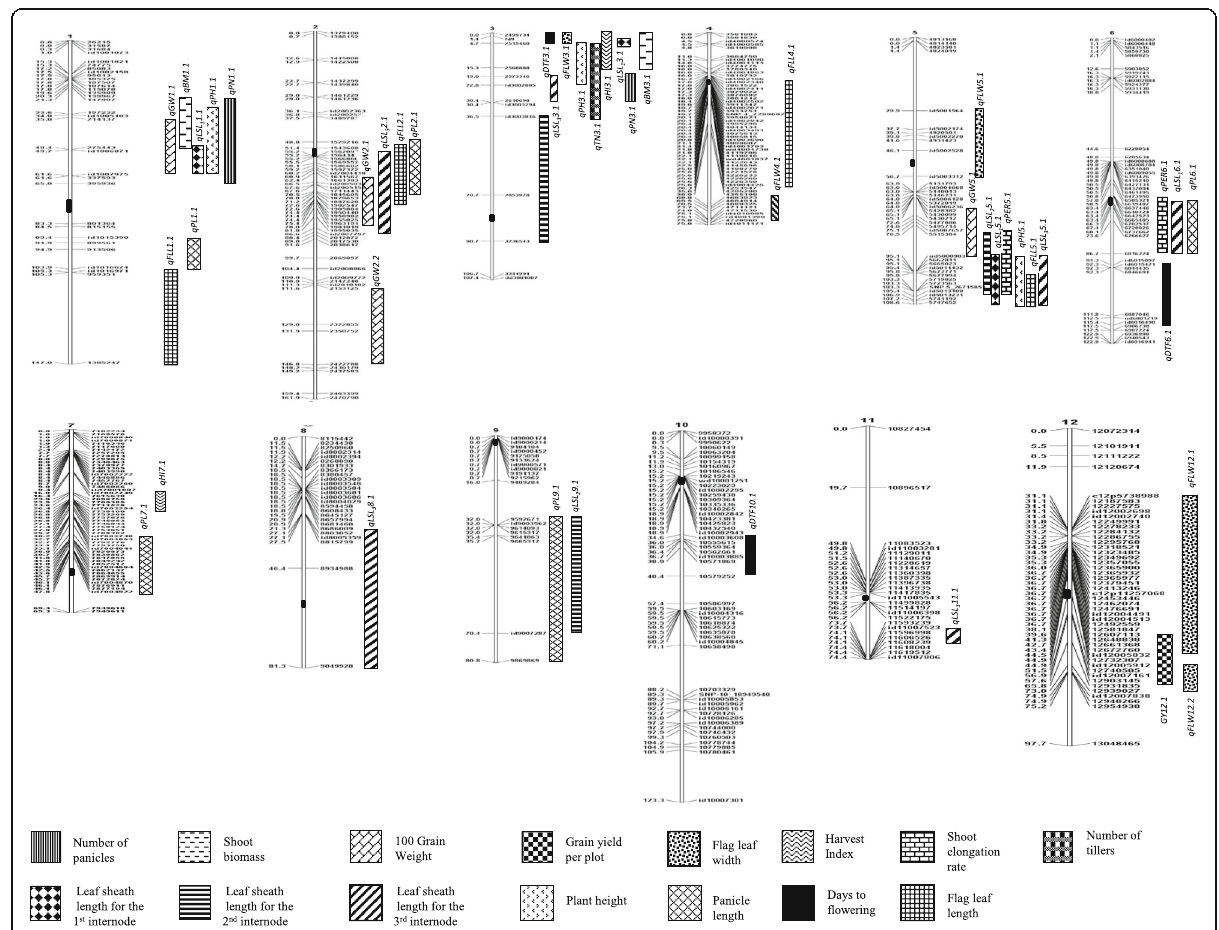
Fig. 2 Linkage map of a RIL population (F 7 ) population derived from a cross between Ciherang-Sub1 and IR10F365 under control irrigated condition along with the positions of QTLs for 15 traits. The QTL boundaries are indicated by the closest flanking markers, traits are indicated by the patterns of the bars. Centromeres are shown as black boxes in each